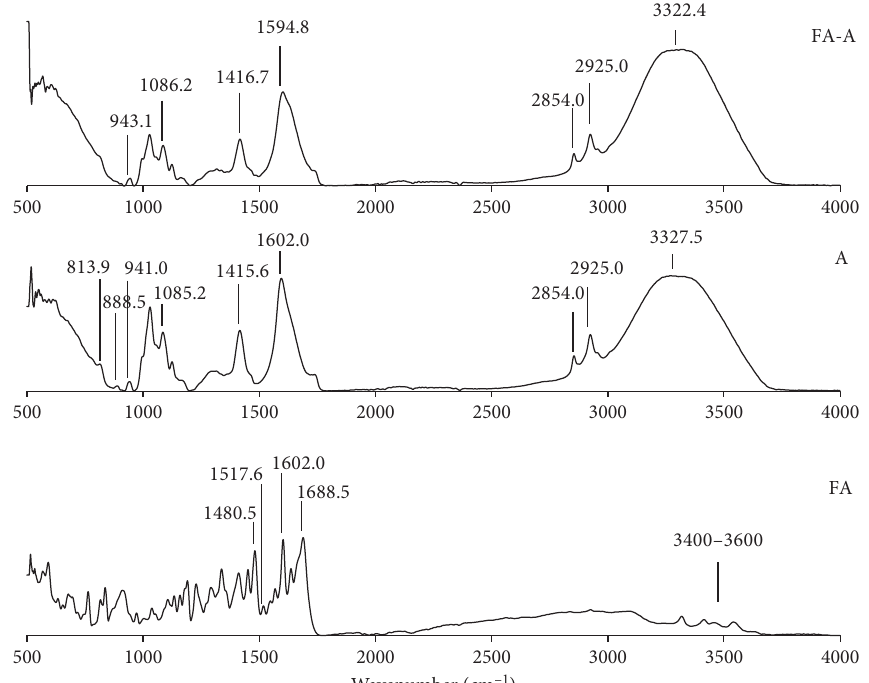
Figure 2: FTIR spectra of free folic acid (FA), alginate empty particles (A), and folic acid encapsulated particles